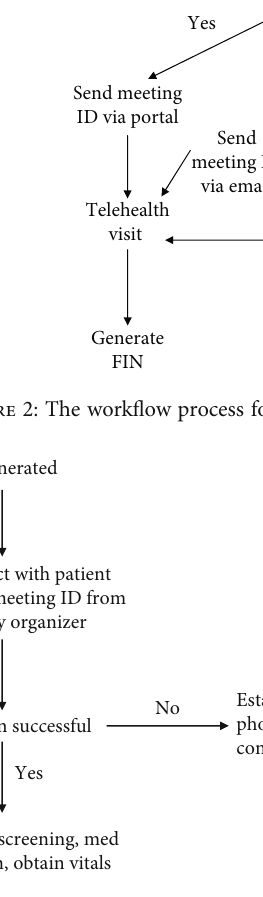
Figure 3: The work fl ow process for previsit nursing screening